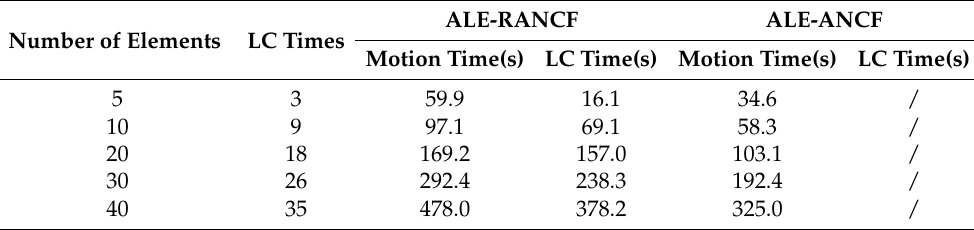
Table 1. Statistical results of simulation time of ALE-RANCF and the ALE-ANCF models. LC is short for length-control.